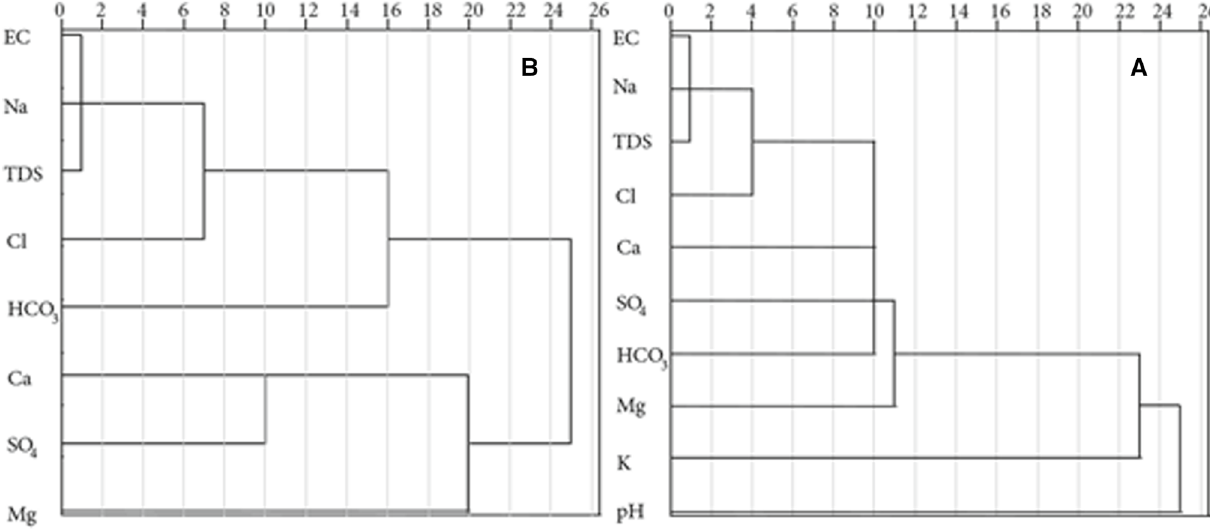
Fig. 5 Dendrogram of the studied parameters of the Karun River in the lake and downstream of the Gotvand-e-Olya Dam; a nearest neighbor method and b wards method (the second-time